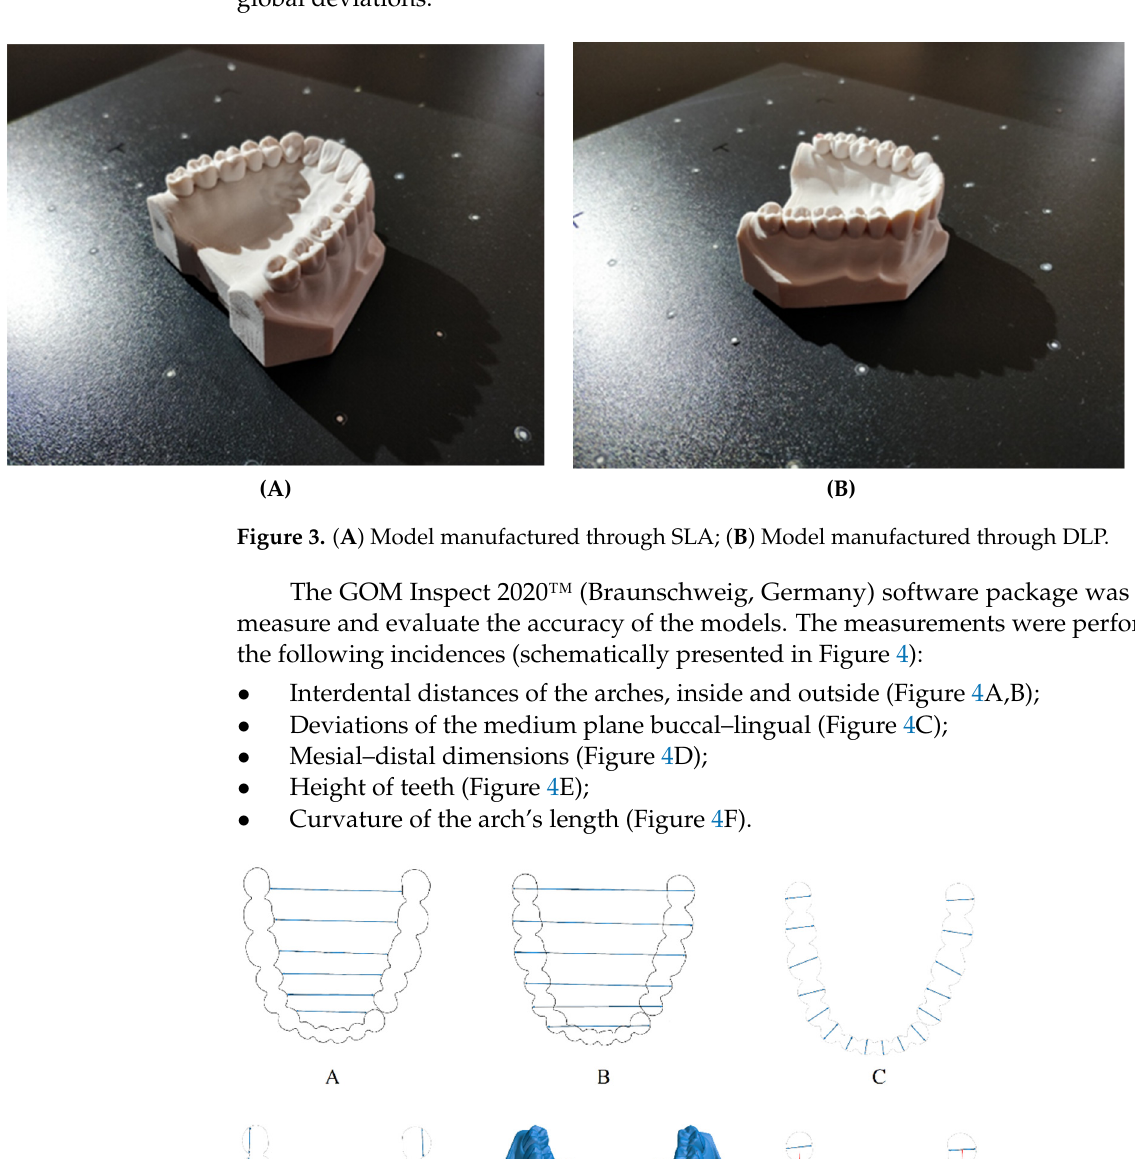
Figure 3. ( A ) Model manufactured through SLA; ( B ) Model manufactured through DLP.